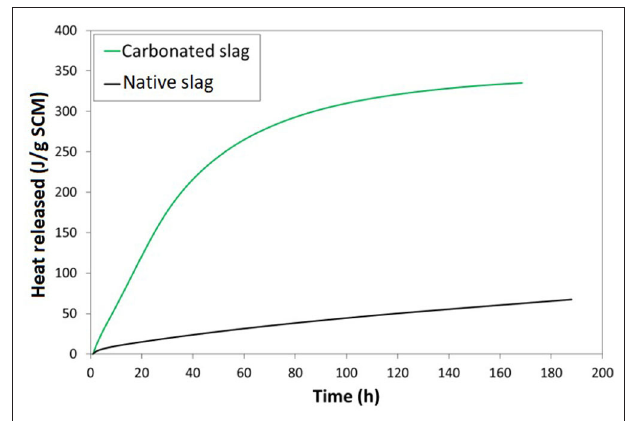
FIGURE 12 | R3 test heat release curves for native and carbonated